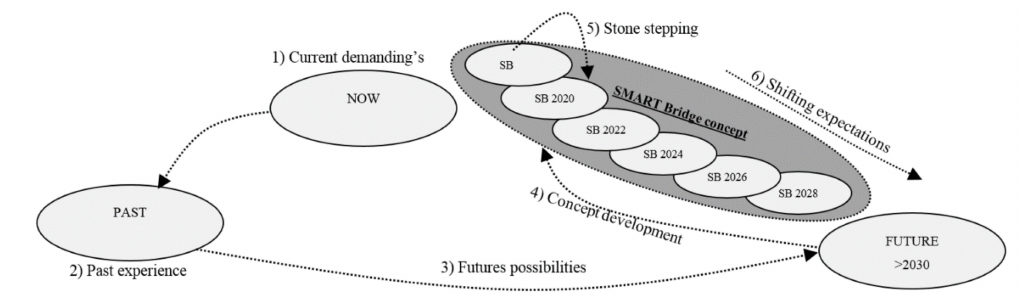
Figure 6. SMART bridge concept development process [13].